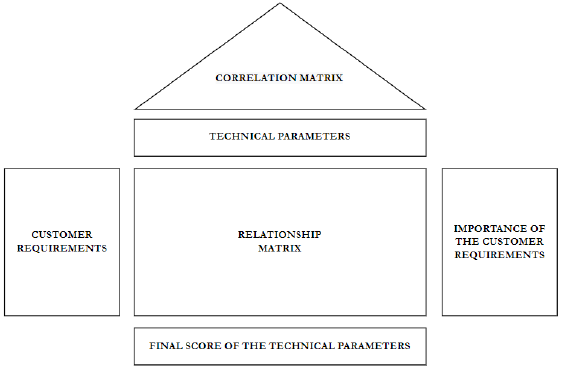
Figure 1. Quality Function